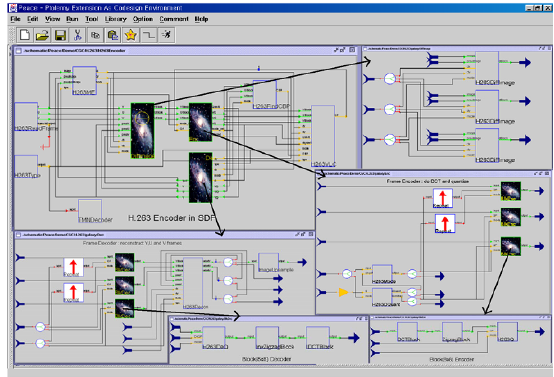
Figure 20: H.263 encoder example that represents a graph of dif- ferent size samples with